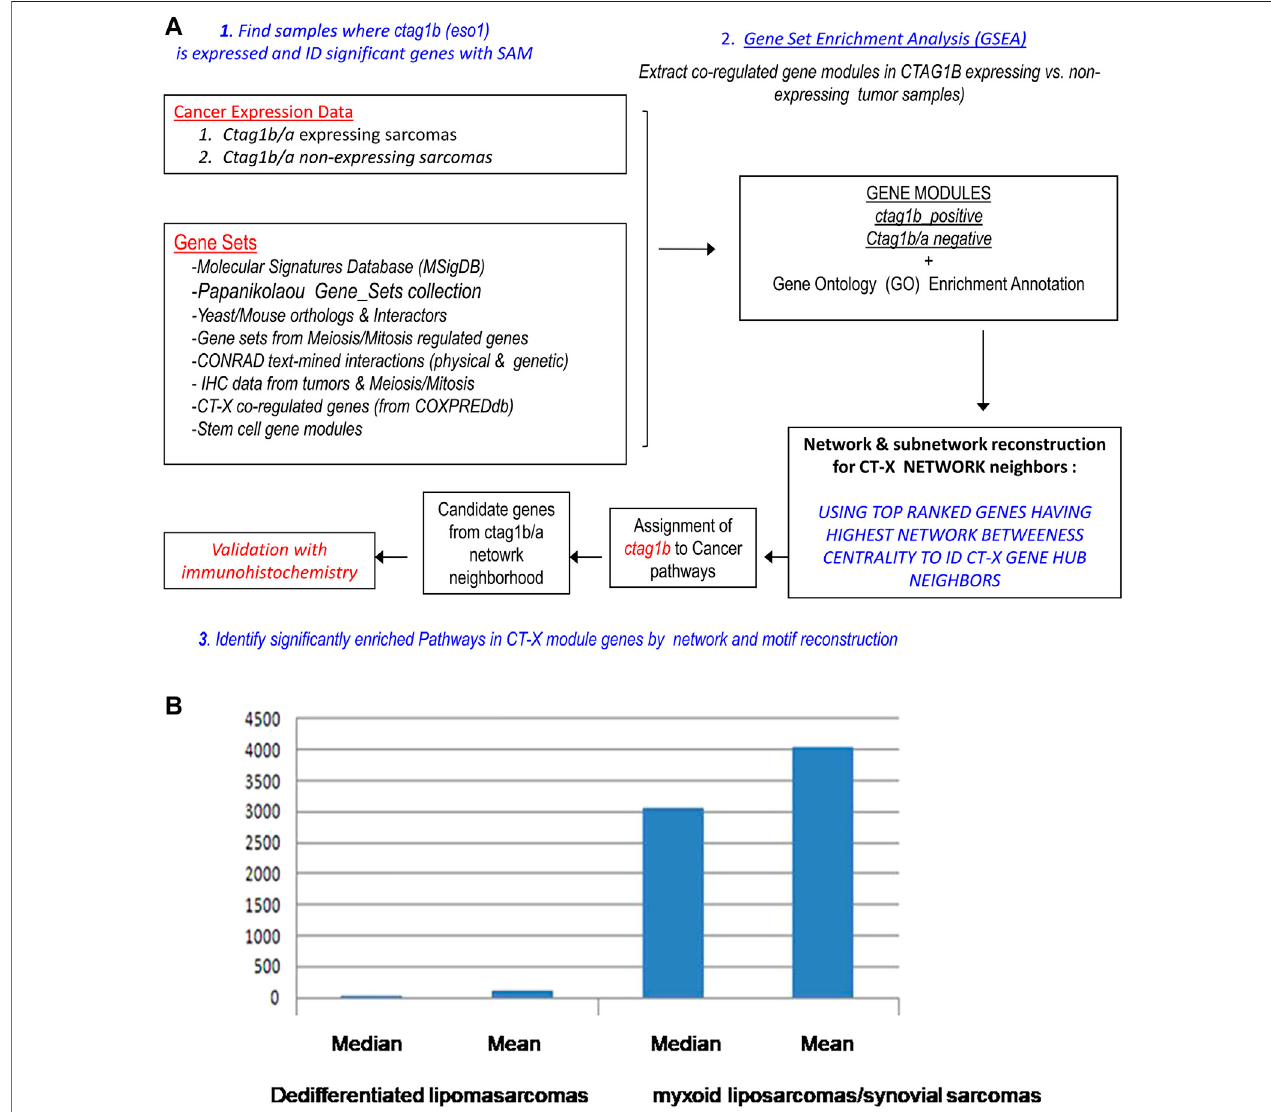
FIGURE 2 | (A) Strategy for the extraction and characterization of synovial ctag1b/a co-expression modules, reconstruction of a synovial ctag1b/a network and identi fi cation of its neighbor genes in the network. (B) Median and Mean values of ctag1b/a expression in differentiated liposarcomas or myxoid liposarcomas/synovial sarcomas.PairwisecomparisonwaswiththeTstatistic( p valuewasequalto3.3×10 – 7 ).Thenullhypothesisisthatthereisnodifferencein ctag1b/a expressionbetween the two groups of tumors. Expression units on Y axis are arbitrary transcriptomics